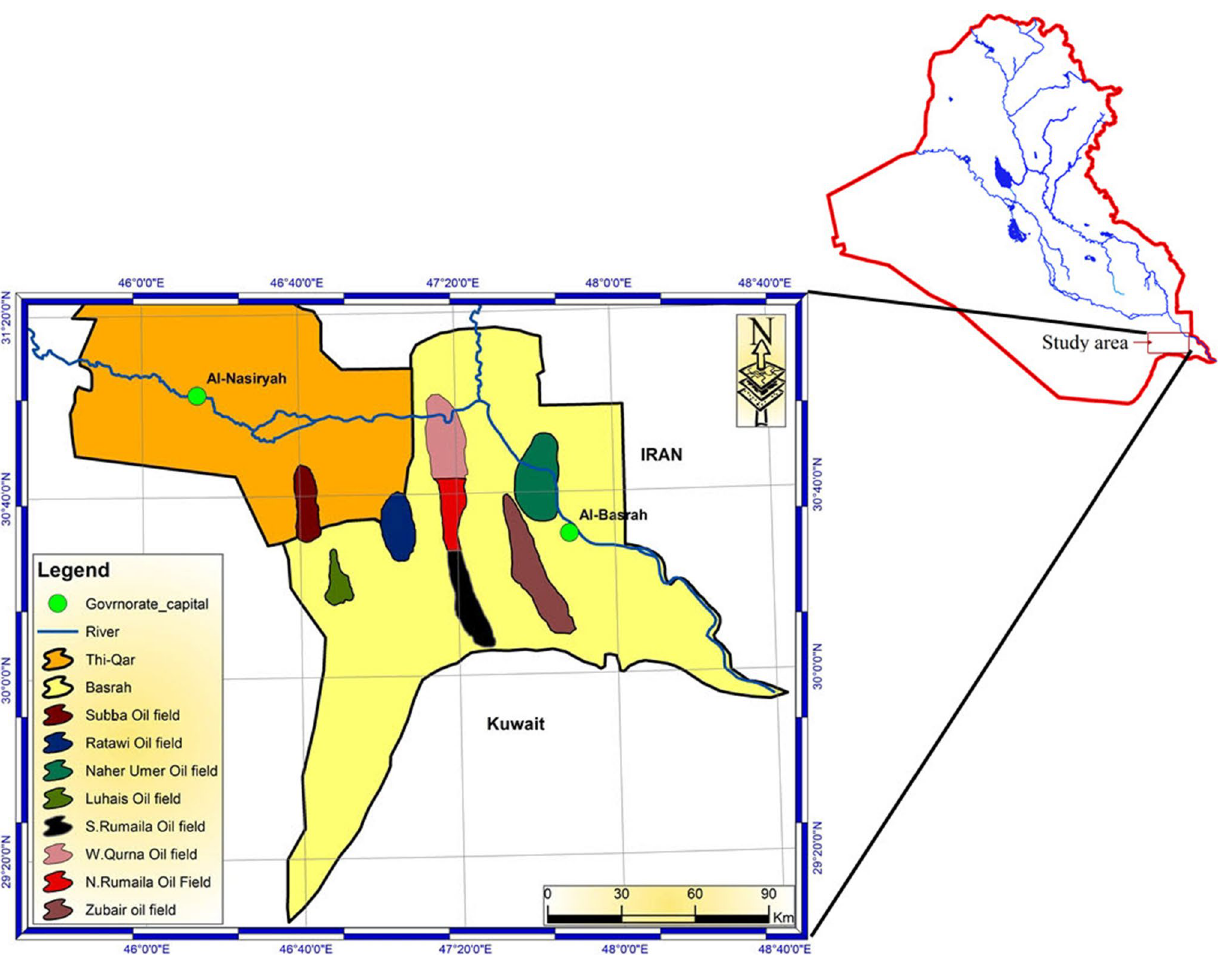
Fig. 1 Location map shows the oilfields